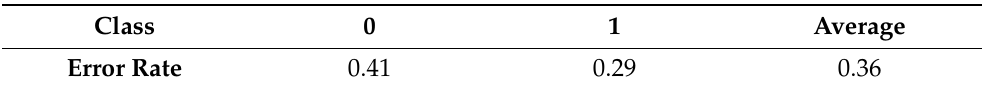
Table 6. Error rates for X. fastidiosa subsp. pauca severity classes using the quadratic discriminant clas-